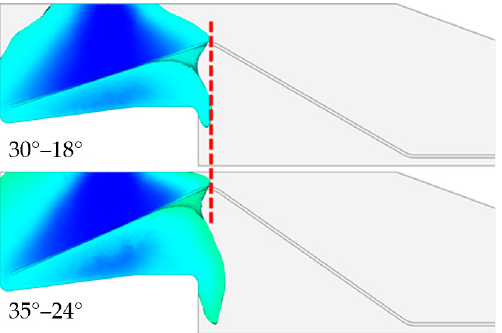
Figure 10. Comparison of the filling situation when the resin flows over the top of the steel wire